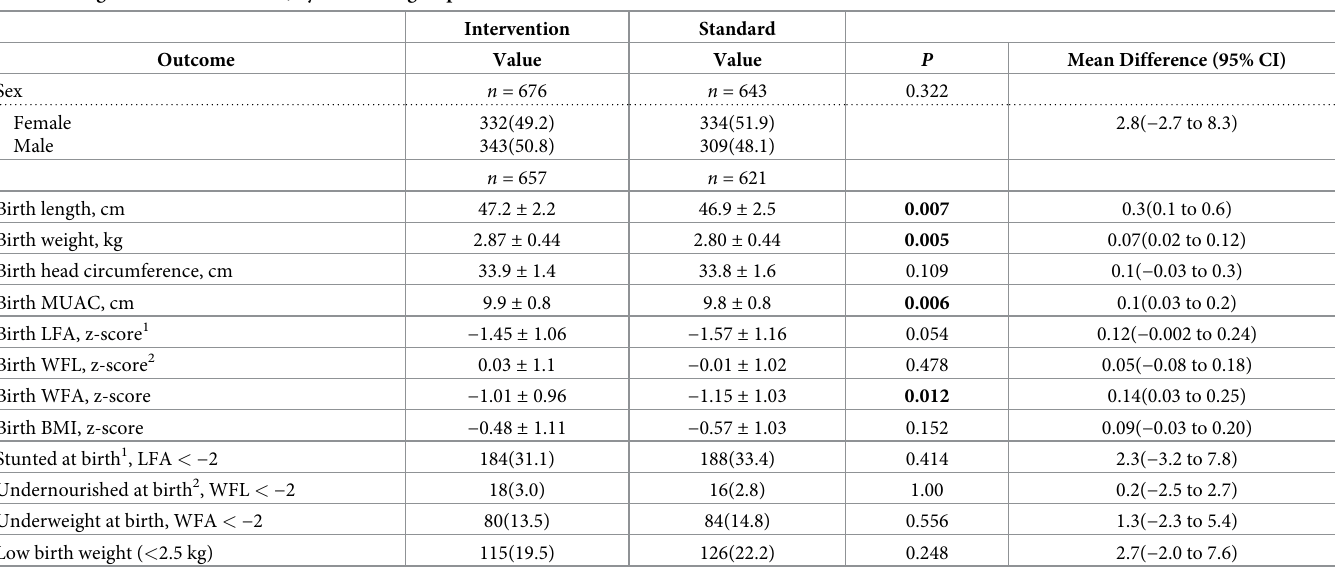
Table 3. Singleton infant outcomes, by treatment group 1